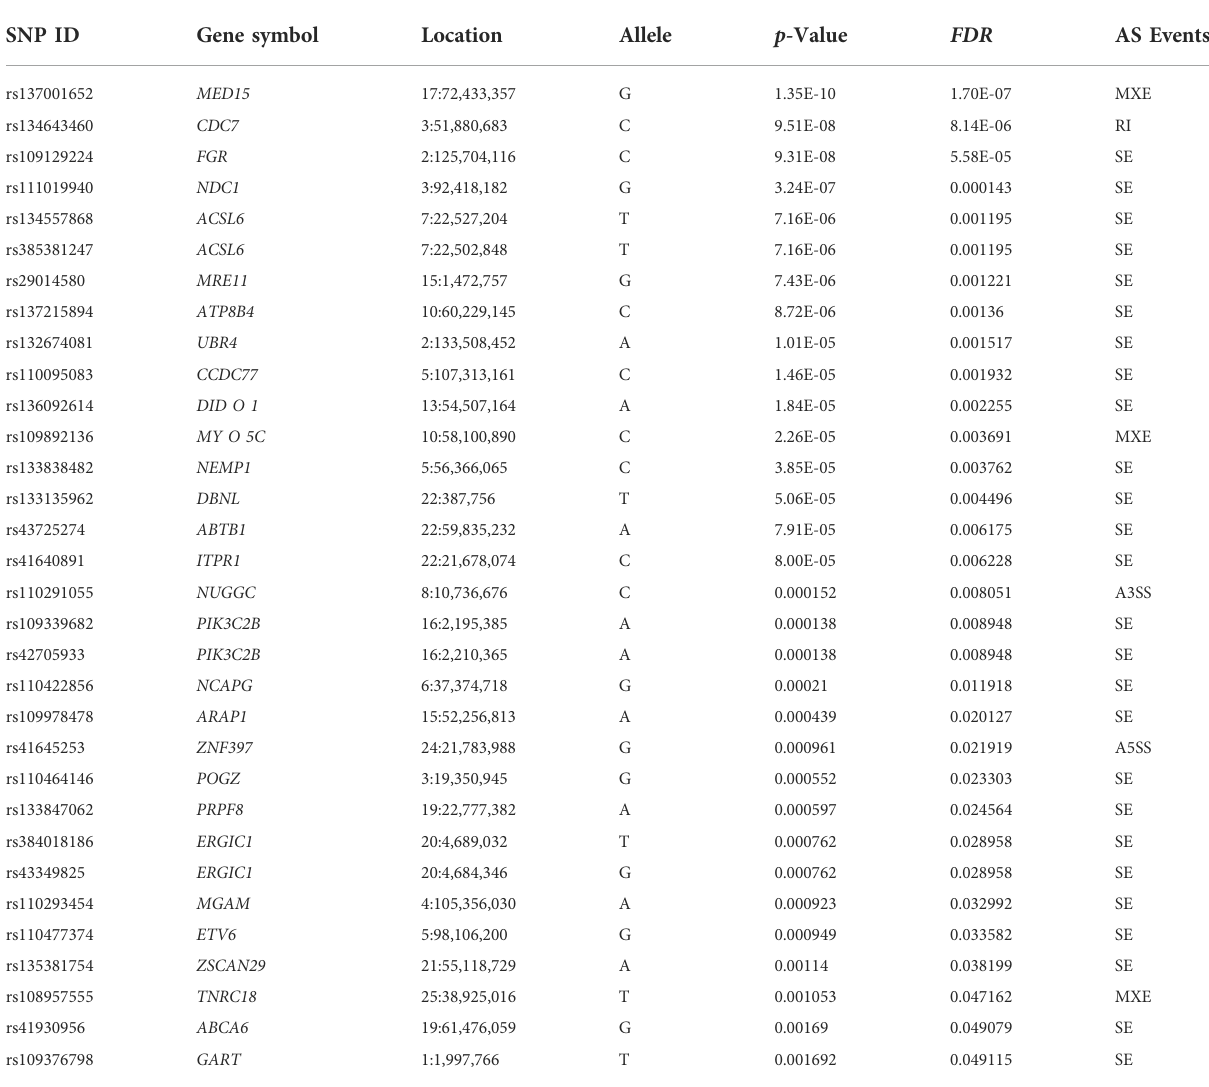
TABLE 2 AS SNPs of all SNPs and the AS events of their target genes. SNP ID Gene symbol Location Allele